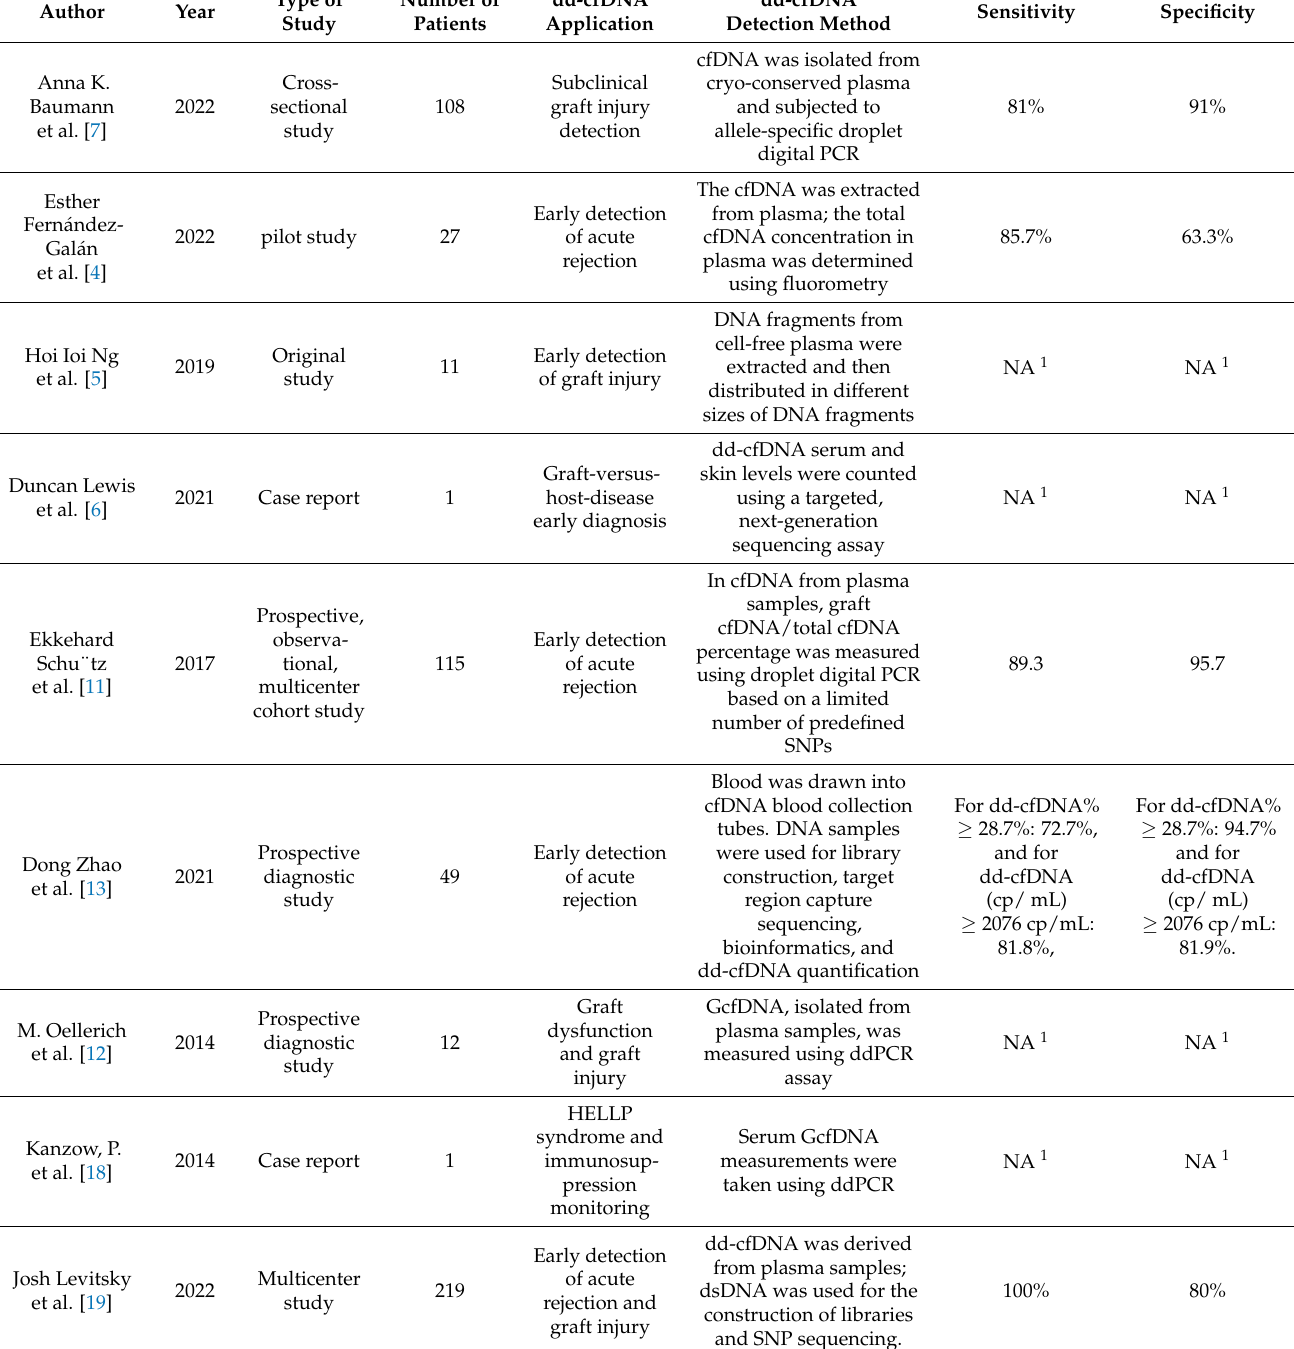
Table 1. Main research articles that referred to dd-cfDNA applications. Type of study, area of application, sensitivity, and specificity of the method employed are mentioned in this